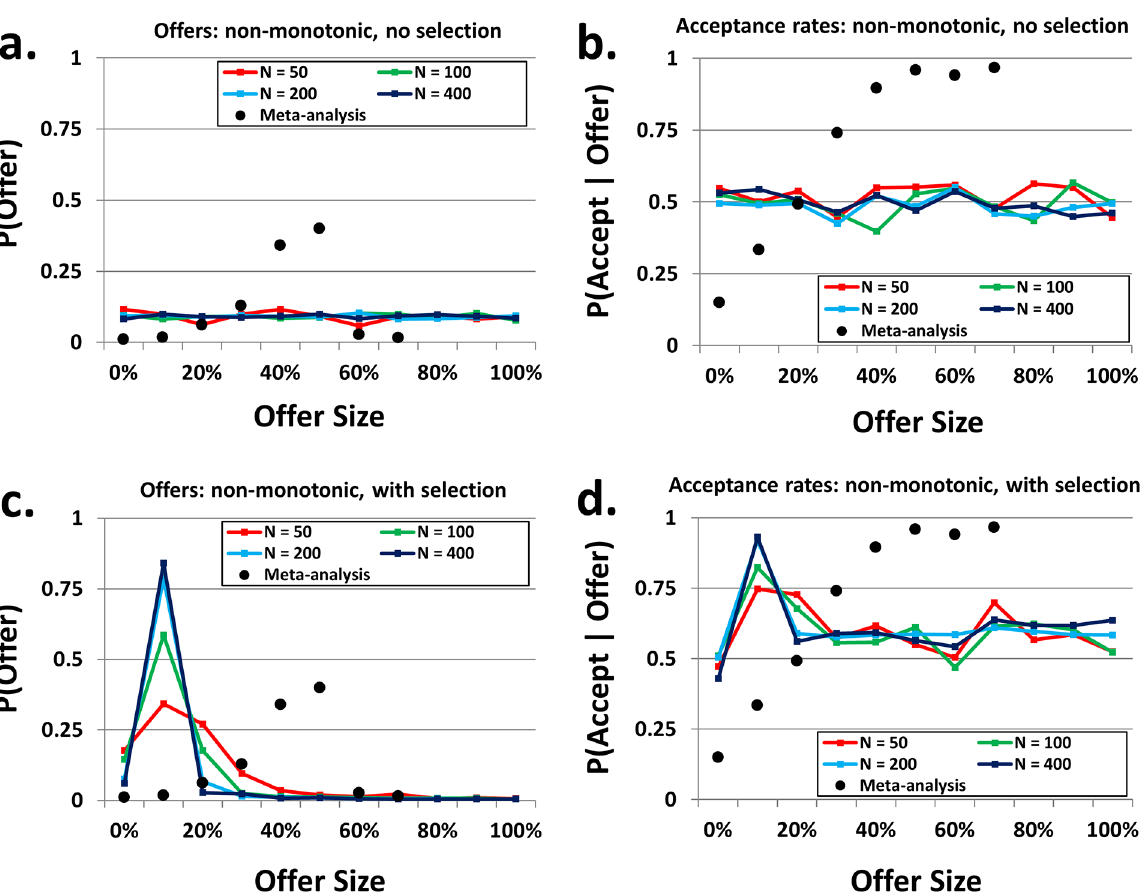
Fig 1. Final genotypes for non-monotonic acceptance rates. The lines in each panel show the mean genotype for each population size across the eleven possible offers. For each panel, black dots denote offer frequencies and conditional acceptance rates of human subjects, according to a meta-analysis of multiple behavioral studies. Because offers greater than 65% are rare in human studies, the rightmost dot comprises all offers of 65% or greater. (a) Frequencies of proposed offers without selection pressure. When the identities of reproducing agents were determined randomly, offer sizes were all equally frequent. (b) Rates of acceptance, conditional upon offer size, without selection pressure. When the identities of reproducing agents were determined randomly, acceptance rates averaged approximately 50% for all offer sizes. (c) Frequencies of proposed offers with selection pressure. When the probability of reproduction was proportional to earnings, populations evolved such that low offers dominated, as expected for maximizing agents. Larger populations adhered to low offers more strictly than smaller populations. (d) Rates of acceptance, conditional upon offer size, with selection pressure. When the probability of reproduction was proportional to earnings, acceptance rates increased for all non-zero offers, with the highest acceptance rates corresponding to the commonly proposed, low